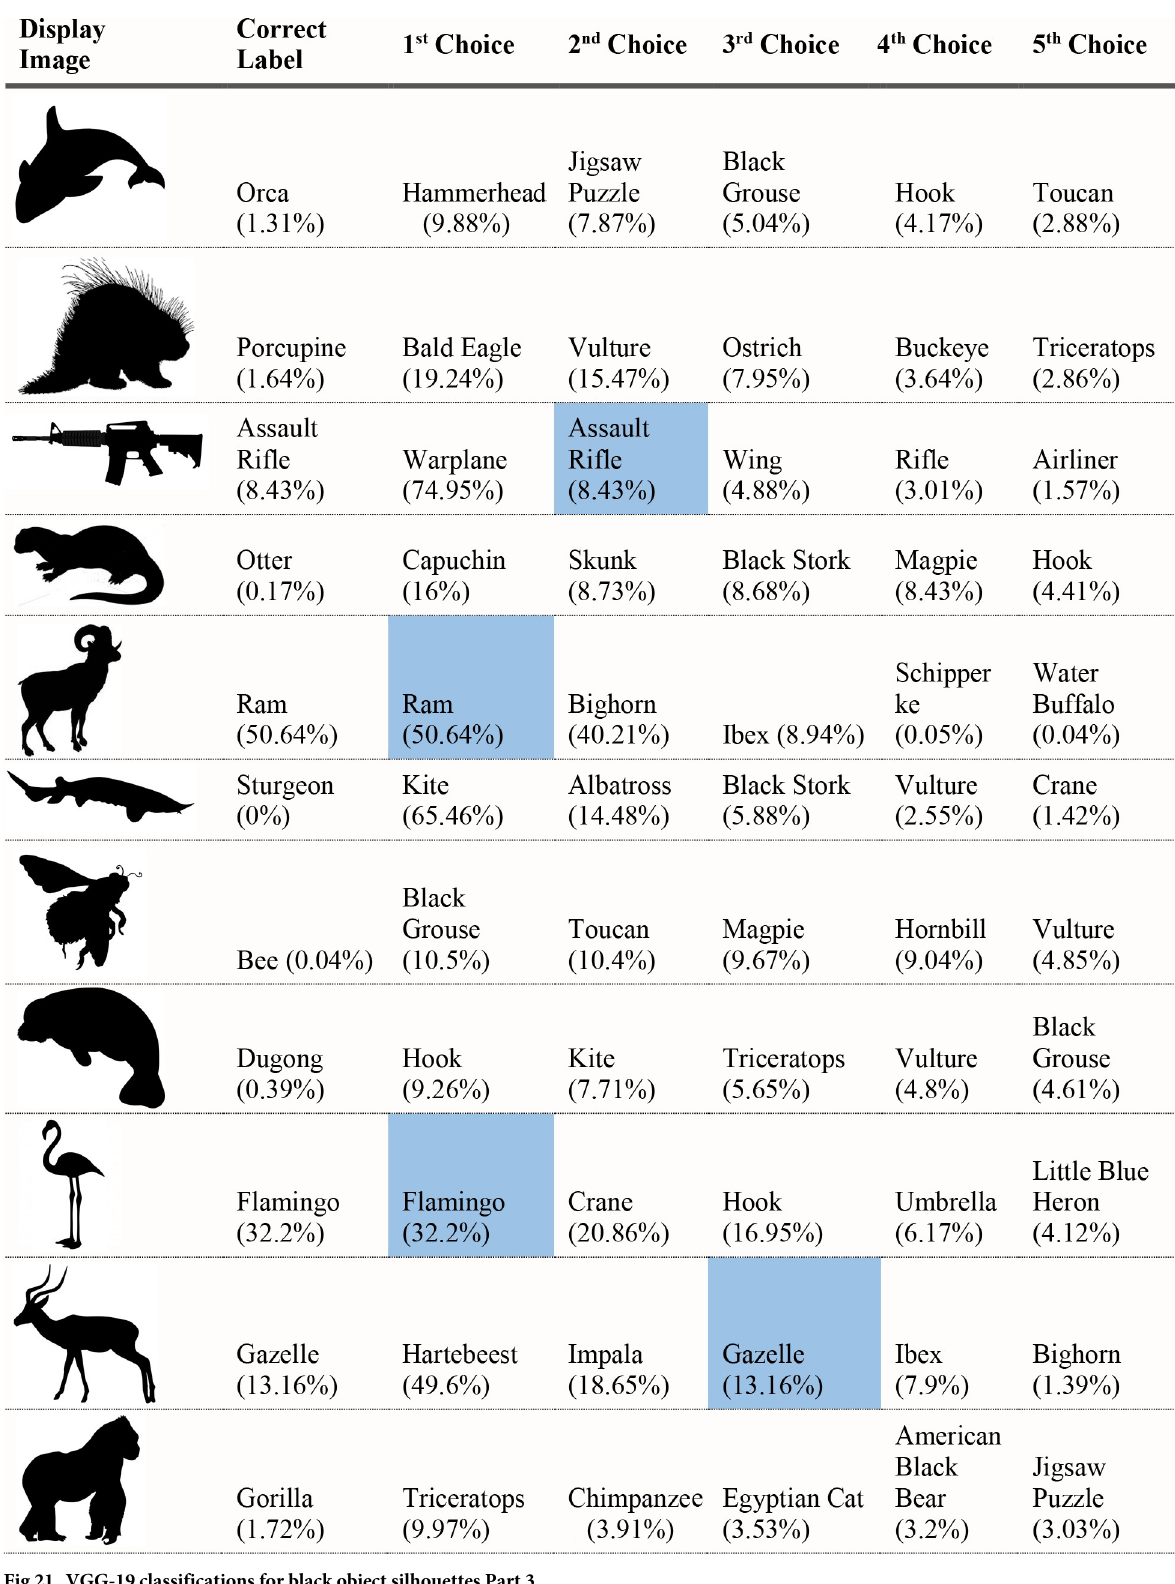
PLOS Computational Biology | https://doi.org/10.1371/journal.pcbi.1006613 December 7,